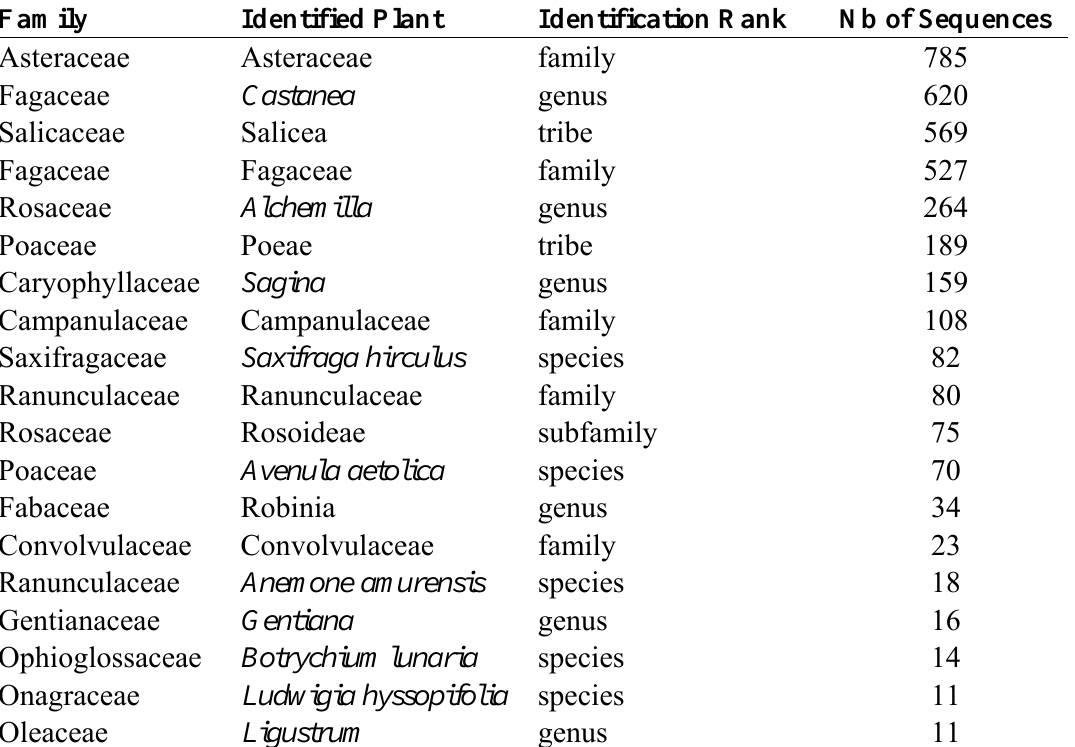
Table 1. Plant taxa identified in the Pyrenean